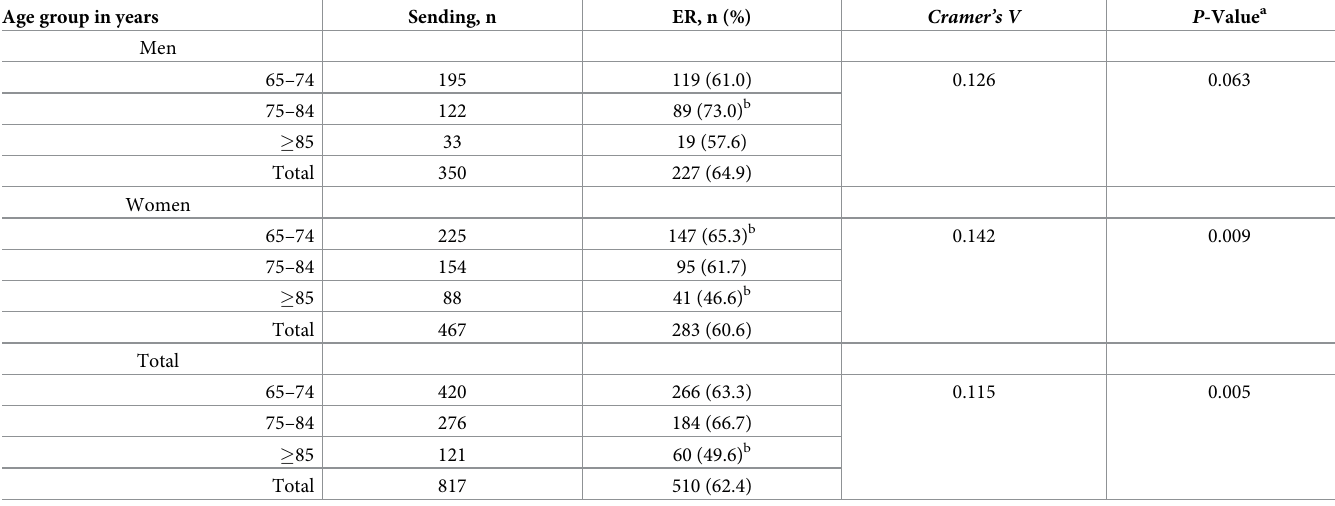
Table 2. Effective response rate in independent older